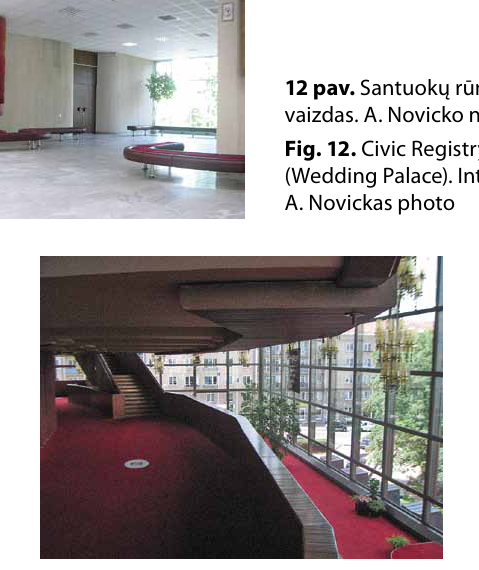
Fig. 14. lobby of the opera and Ballet Theatre. a. novickas